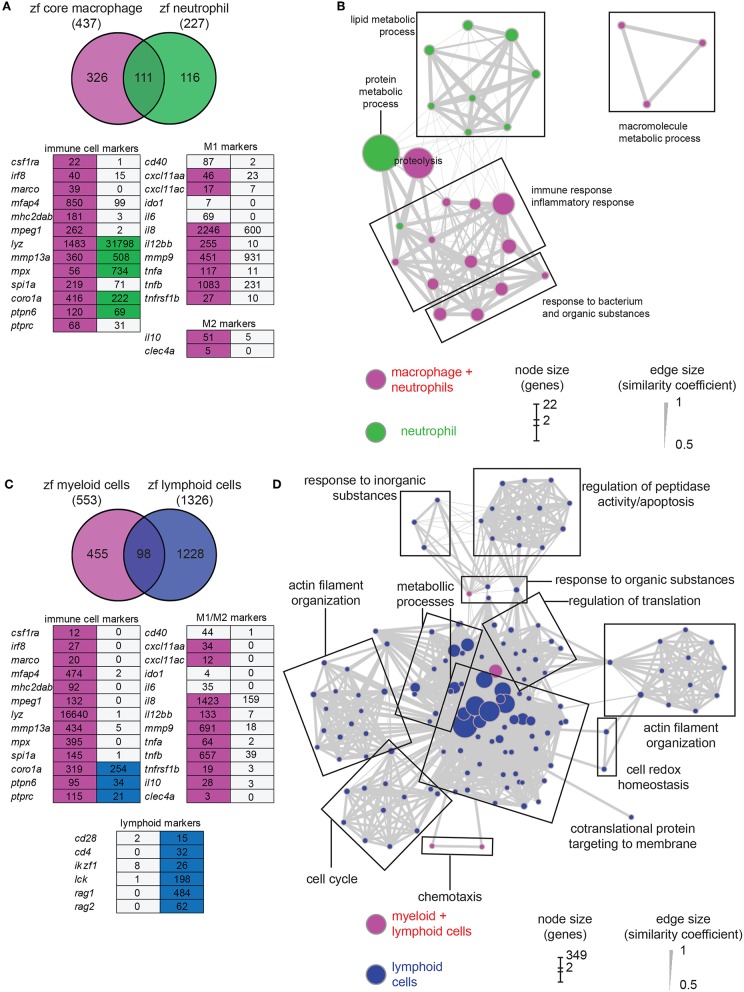
Comparison of macrophage core dataset with neutrophils and lymphoid cells expression sets. (A) Overlap of the genes from the zfM core data set (magenta) and the genes enriched [log2 (fold change) > 1, P-adj < 0.01] when comparing mpx:gfp positive and negative cells from 5 dpf transgenic fish (green). Below is represented an expression table of a selection of immune cell specific genes. Magenta cells and green cells represent genes enriched in macrophages or neutrophils, respectively, whereas gray cells represent non-enriched genes. Numbers are expression levels expressed in TPM in fluorescence positive cells. (B) Network visualization of GO enrichment analysis of genes from the neutrophil expression data set using BiNGO and EnrichmentMap. Green nodes are terms found exclusively in neutrophil expression dataset and magenta nodes are found in both core macrophage and neutrophil data sets. Network legend is similar to Figure 1C. (C) Overlap of the genes from the myeloid data set corresponding to genes found either in the core macrophage or the neutrophil expression data sets (magenta) and the genes enriched (log2 (fold change) > 1, P-adj < 0.01) when comparing lck:gfp positive and negative cells in 5 dpf lck:gfp transgenic fish (blue). Below is represented an expression table of a selection of immune cell specific genes. Magenta cells and blue cells represent genes enriched in myeloid or lymphoid cell populations, respectively, whereas gray cells represent non-enriched genes. Numbers are expression levels expressed in TPM in fluorescence positive cells (for myeloid cells, expression levels in macrophage and neutrophil populations were averaged). (D) Network visualization of GO enrichment analysis of genes from the lymphoid expression data set using BiNGO and EnrichmentMap. Blue nodes are terms found exclusively in lymphoid expression dataset and magenta nodes are found in both myeloid and lymphoid data sets. Network legend is similar to Figure 1C.